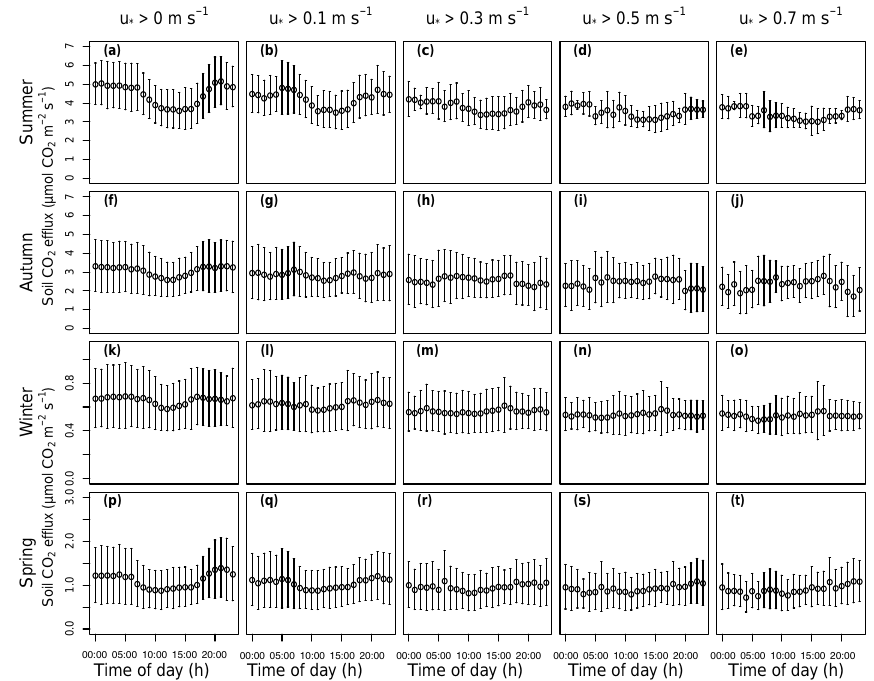
Figure 5. Seasonally averaged diurnal patterns of soil CO 2 efflux ( ± standard deviation), at different friction velocity ( u ∗ ) threshold values, measured by the eight automated chambers for each of the four seasons. From the top, the four rows show the diurnal patterns for summer, autumn, winter and spring respectively. From the left, the five collars show the diurnal patterns for each season at no u ∗ filtering, a u ∗ threshold value of 0.1ms − 1 , a u ∗ threshold value of 0.3ms − 1 , a u ∗ threshold value of 0.5ms − 1 and a u ∗ threshold value of 0.7ms − 1 respectively.